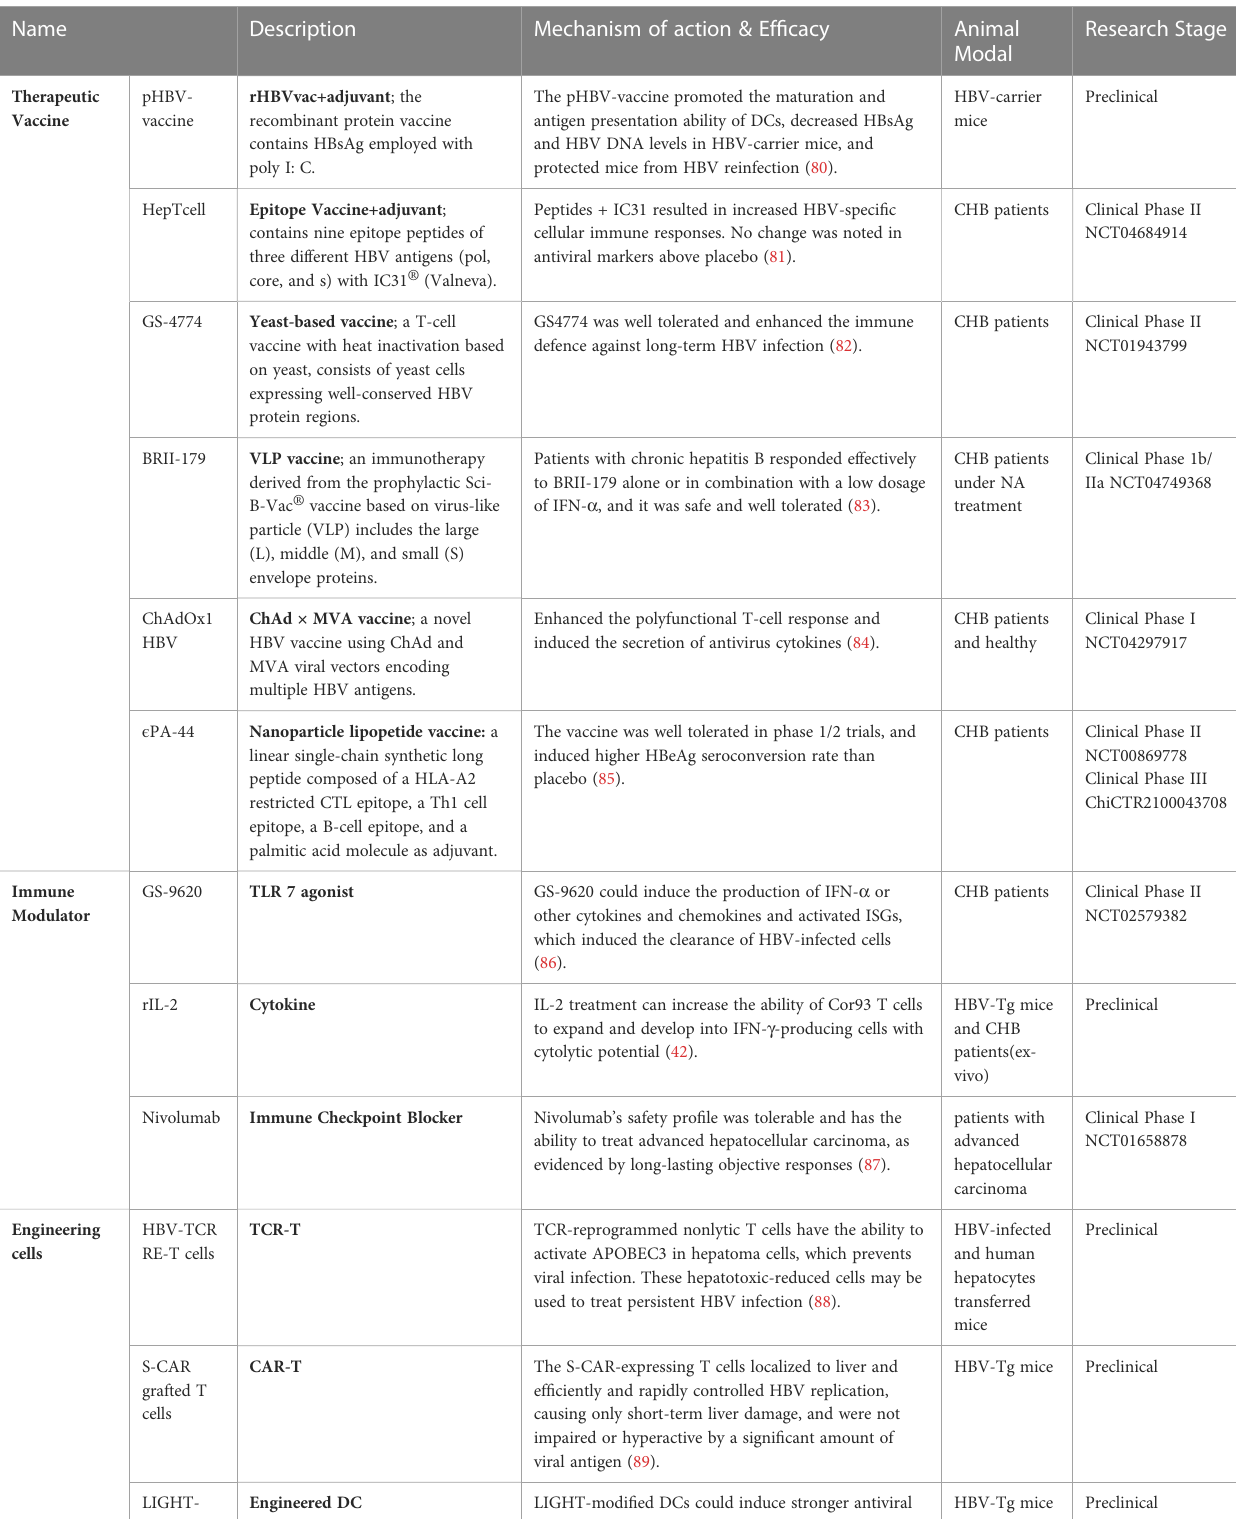
TABLE 1 Immunotherapy for chronic hepatitis B